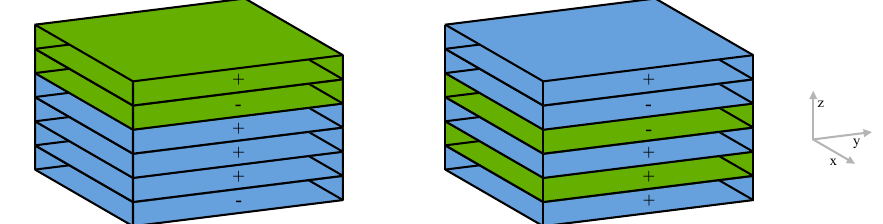
Figure 4. Two possible arrangements along the z direction of quiver blocks associated to the a pair of perfect matchings leading to the same CY 4